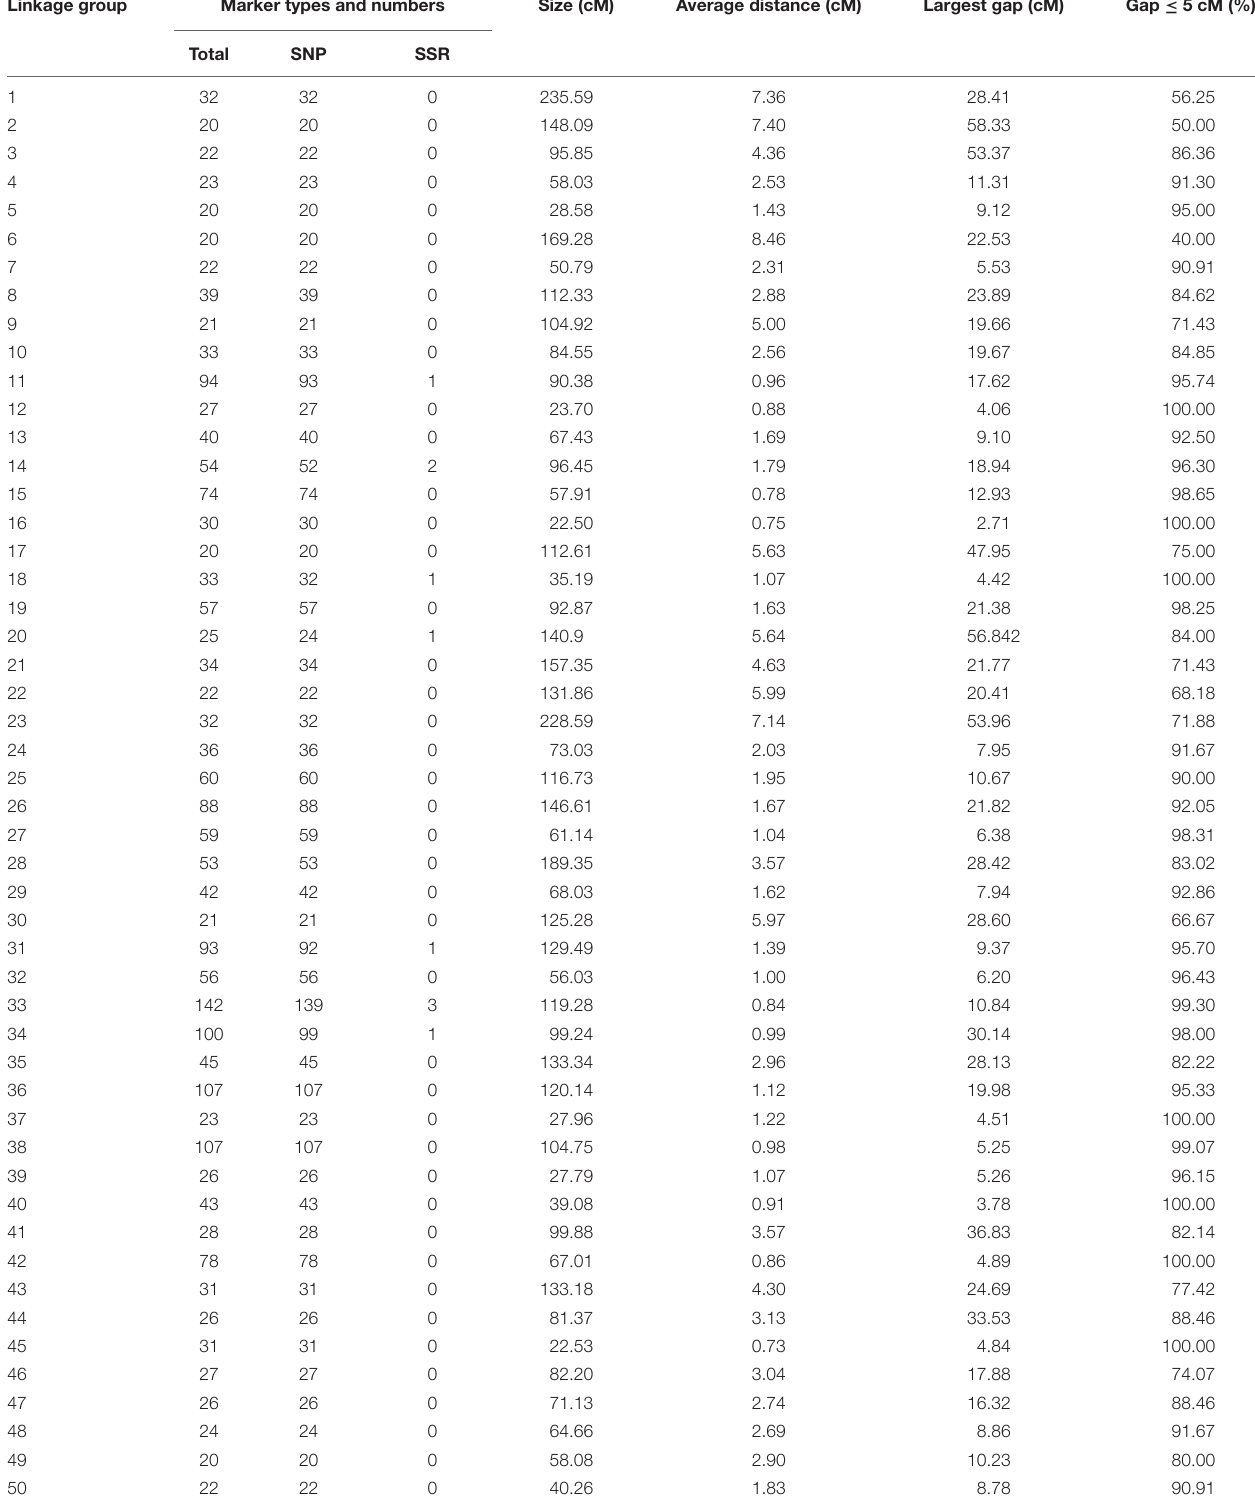
TABLE 3 | Descriptions of characteristics of 60 linkage